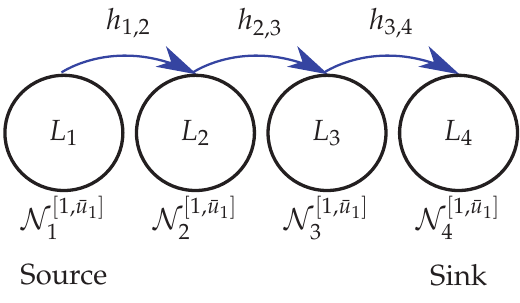
Figure A1. Network for the appendix